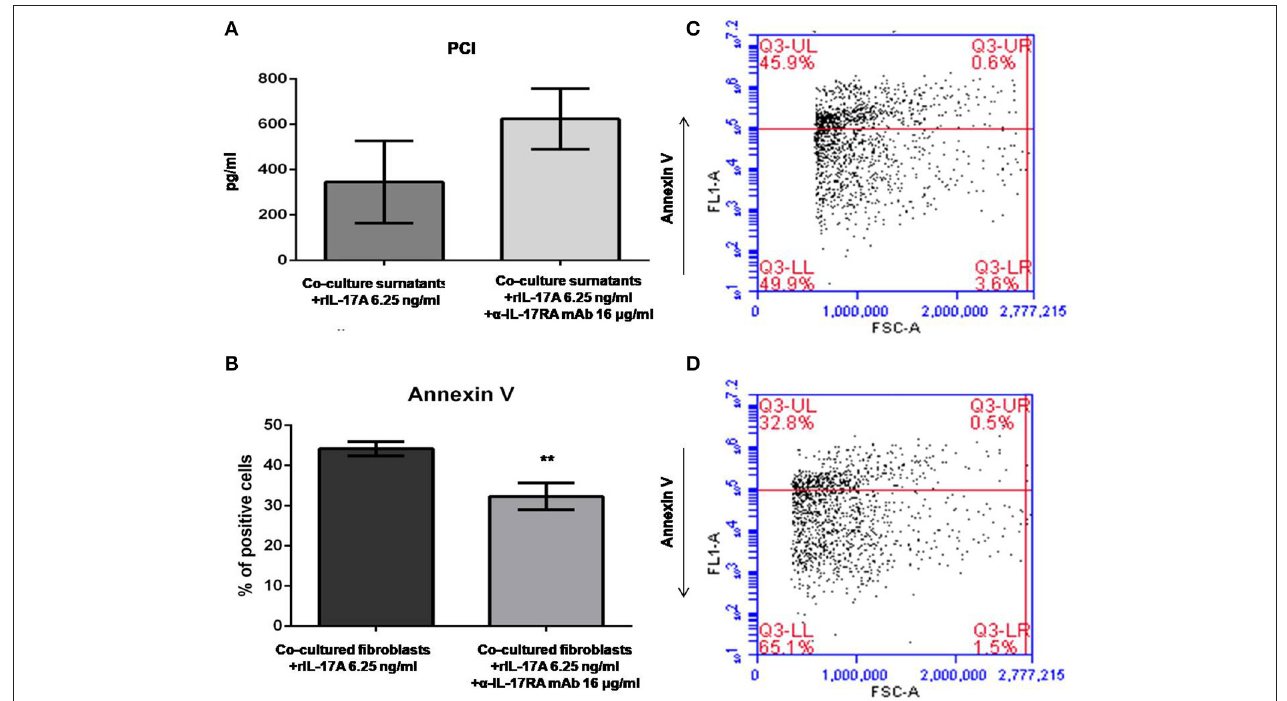
FIGURE 4 | PCI concentration and SSc fibroblast apoptosis in co-cultures exposed to either IL-17A or IL-17A + α -IL-17A mAb. (A) Shows that concentrations of PCI in supernatants from SSc PBMC–fibroblast co-cultures treated with ectopic rhIL-17A 6.25ng/ml are decreased, while simultaneous treatment of these co-cultures with ectopic rhIL-17A and a neutralizing mAb against IL-17RA subunit, α -IL-17A mAb16 µ g/ml, increases PCI production (number of samples per group = 3). (B) Shows that α -IL-17A mAb at the same concentration is able to reduce significantly the apoptotic rate of co-cultured SSc fibroblasts exposed to rhIL-17A (number of samples per group = 5). Data are mean ± SD, paired Student’s t -test. ** p < 0.01. The scatterplot graph in panel (C) shows the percentage of apoptotic fibroblasts co-cultured with autologous PBMCs obtained from a representative SSc patient, added with ectopic rhIL-17A 6.25ng/ml. The scatterplot graph in panel (D) shows the percentage of apoptotic fibroblasts co-cultured with autologous PBMCs obtained from the same representative SSc patient, added with both ectopic rhIL-17A 6.25ng/ml and α -IL-17A mAb16 µ